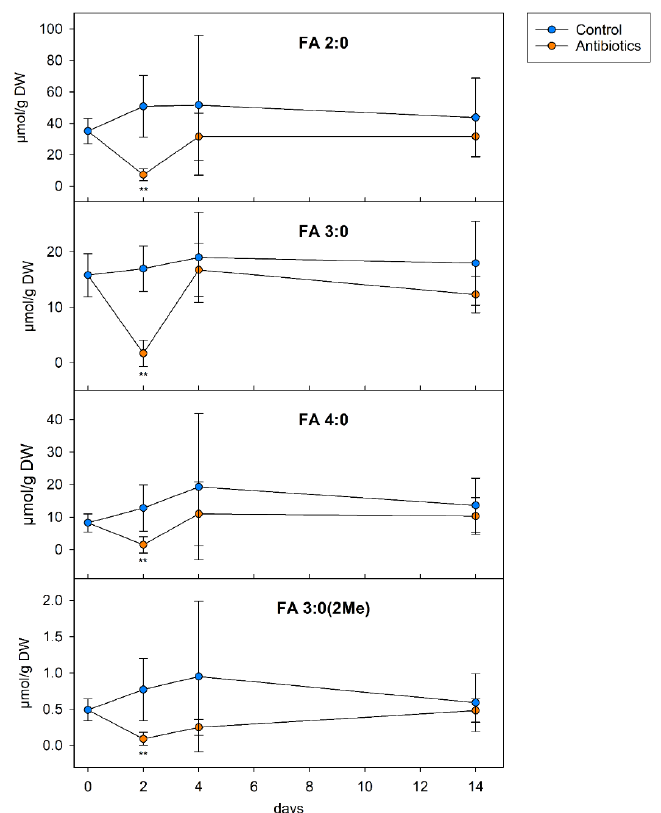
Figure 3. SCFA levels in the colon content of SPF mice treated with antibiotics. Specific pathogen-free mice were treated for two days with a combination of vancomycin and metronidazole (antibiotics). After treatment, the mice obtained a regular chow diet without antibiotics for an additional 2 or 12 days. The colon content was analyzed at the indicated time points ( n = 6 each data point). For three samples with antibiotic treatment, the (day 2) FA 4:0 and FA 3:0 (2Me) concentrations were below limit of detection LoD; for these samples, two-thirds of the LoD were imputed.